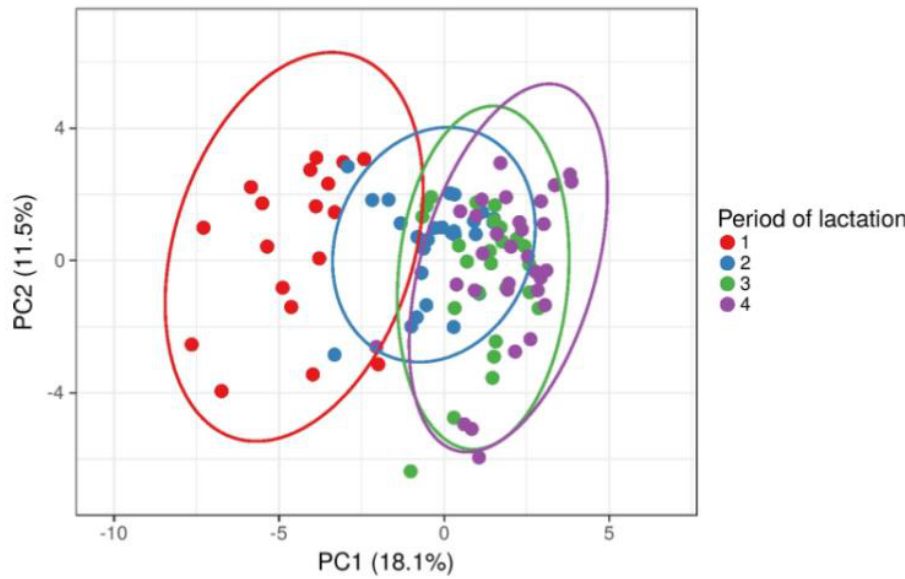
Figure 1. Principal components analysis (PCA) and clustering of cows based on lactation period (early—1, mid—2, full—3 and late—4) after including all blood and milk metabolic parameters. Blood biochemical parameters in cows during the four lactation periods are summa- rized in Table 1. Serum NEFA and BHB concentrations were highly significantly greater in early lactation cows than in cows during the other lactation periods ( p < 0.001), whereas mean TG and TChol concentrations were significantly lower ( p < 0.01) in early lactation cows. In addition, glucose, TP, globulin and urea levels were significantly lower in Group 1 (early lactation) cows ( p < 0.01), which also exhibited a slight (but not significant) decrease in albumin concentration. By contrast, TBil and serum AST, ALT, ALP and LDH activi- periods of lactation ( p <